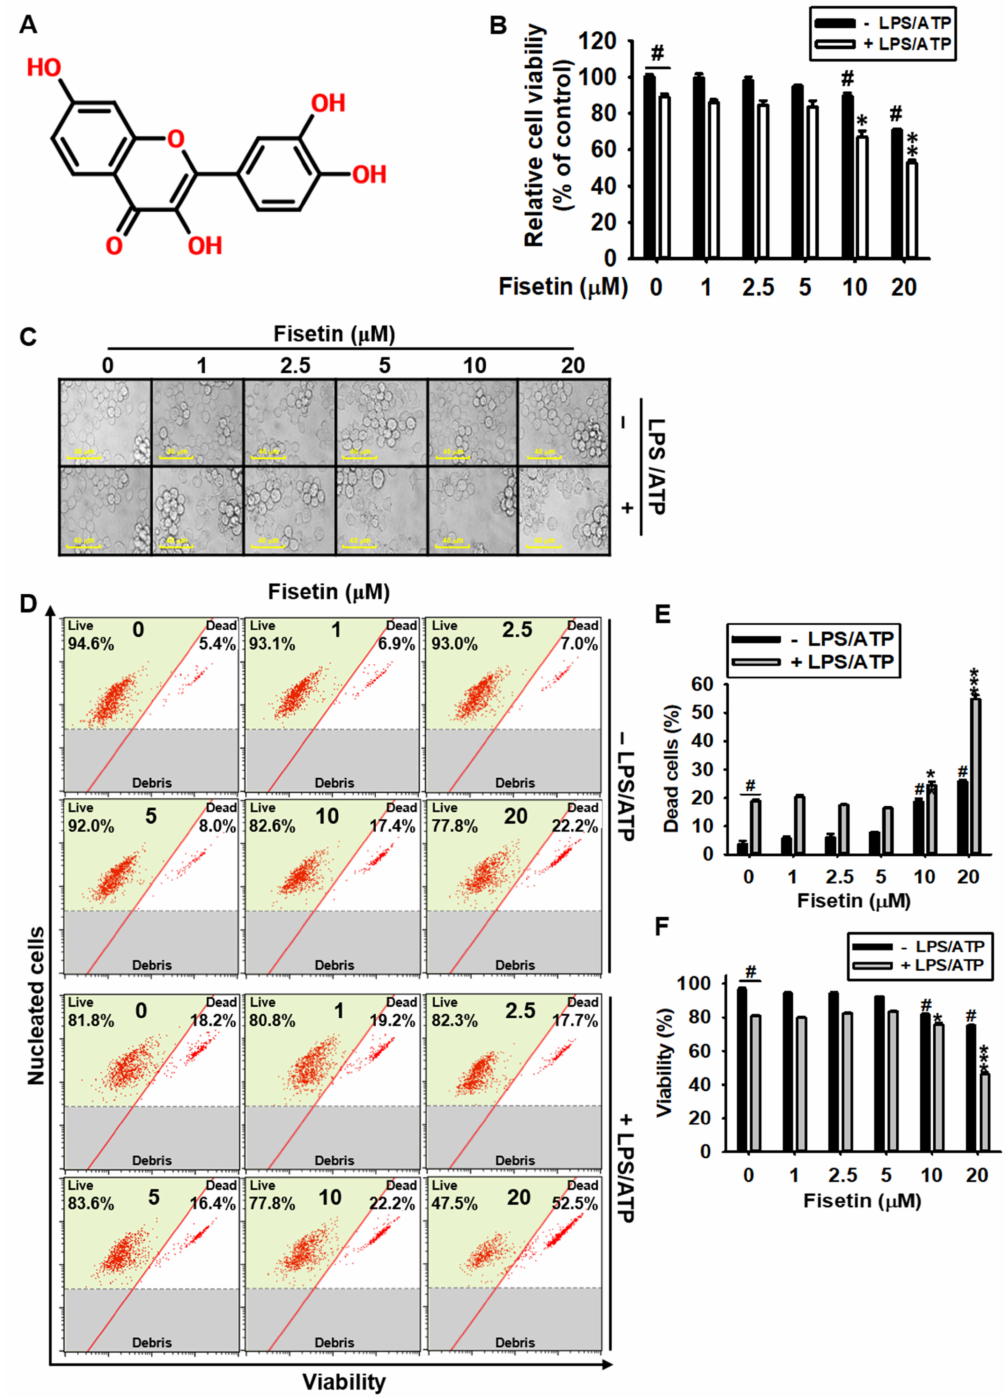
Figure 1. High concentrations of fisetin are cytotoxic to BV2 microglial cells. ( A ) Chemical structure of fisetin. BV2 microglial cells were treated with the indicated concentrations of fisetin (0–20 µ M) for 2 h in the presence or absence of 1 µ g/mL LPS for 2 h, followed by treatment with 1 mM ATP (LPS/ATP) for 24 h. ( B ) Cell viability was analyzed using an MTT assay. ( C ) Images of the cells were captured using phase-contrast microscopy ( × 10). ( D ) The population of dead and viable cells (%) was measured using a Muse Cell Count & Viability Kit. ( E , F ) Graphical representation of the population of ( E ) dead and ( F ) viable cells. The results indicate the mean ± standard error median (SEM), and is representative of the results obtained from three independent experiments. # p < 0.05 vs. untreated cells; *** p < 0.001, ** p < 0.01, and * p < 0.05 vs. LPS/ATP-treated